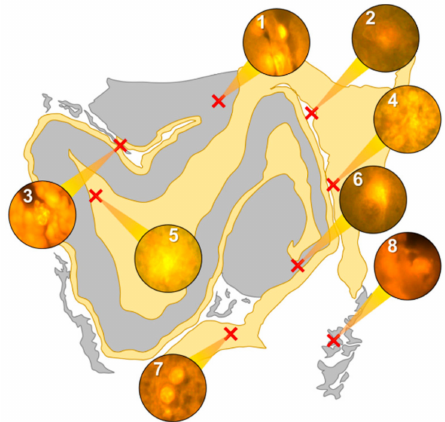
Figure 4. Schematic depicting a 5 µ m tissue section of the hippocampus. White matter and grey matter are highlighted yellow and grey, respectively. Lumogallion-reactive aluminium was identified through sequential scanning of a 5 µ m tissue section, with positive bright orange fluorescence denoted by red crosses